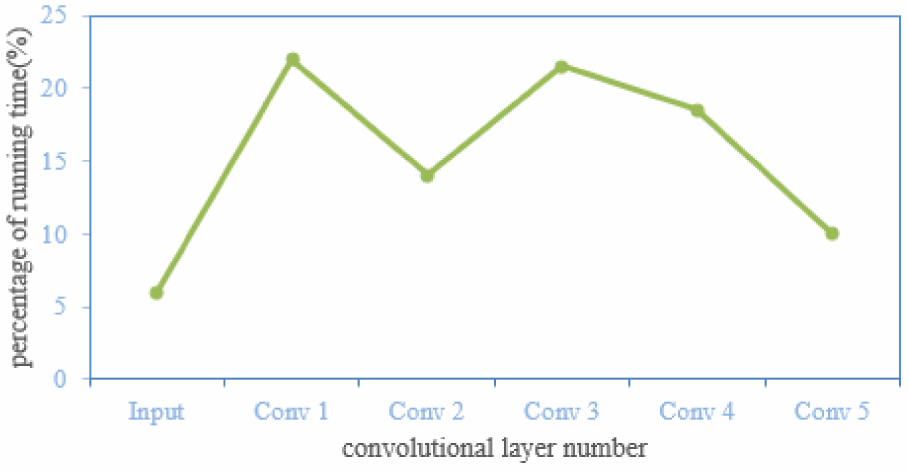
Figure 3. Percentage of running time of convolutional